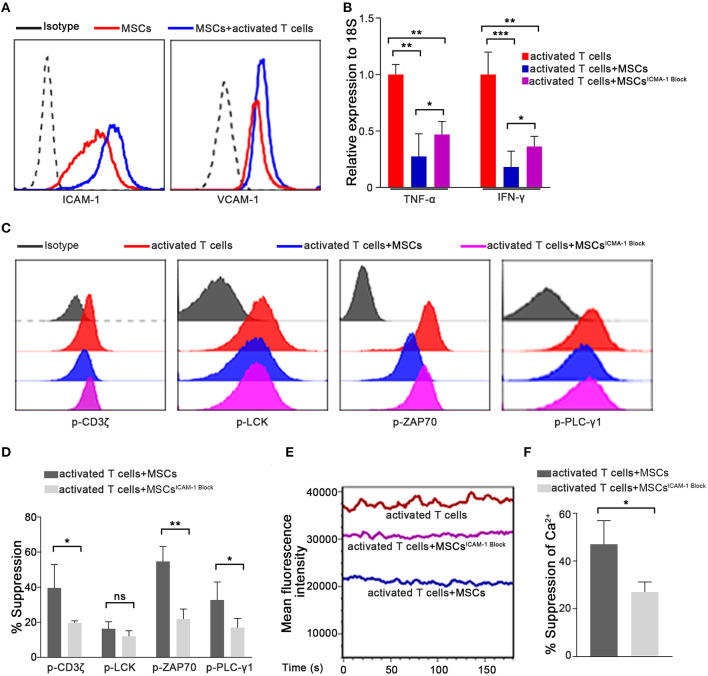
The ability of MSCs to rapidly suppress activated T cell cytokine transcription is dependent on ICAM1-mediated cell-to-cell contact. (A) Expressions of ICAM-1 and VCAM-1 on the membranes of MSCs determined by flow cytometry are shown. All experiments were repeated at least three times using the sixth passage MSCs. (B) The mRNAs abundances of TNF-α and IFN-γ in activated T cells. Data are shown for activated T cells, activated T cells cocultured with MSCs, and activated T cells cocultured with ICAM-1-blocked MSCs. (C) Phosphorylation levels of CD3ζ, LCK, ZAP70, and PLC-γ1 in activated T cells from the three groups described above were examined by flow cytometry. The results presented are representative of those obtained from three independent experiments. (D) Bar graphs show the suppression percentages of p-CD3ζ, p-LCK, p-ZAP70, and p-PLC-γ1. Data are shown for activated T cells cocultured with MSCs and activated T cells cocultured with ICAM-1-blocked MSCs. All experiments were repeated three times. (E) Cytosolic Ca2+ levels were tested by flow cytometry. The mean fluorescence intensity (MFI) is shown. The experimental groups are the same as described in (B). (F) Suppression percentages of the Ca2+ level in activated T cells from the coculture groups. The results are representative of three independent experiments. Data are presented as the mean ± SEM for each group. Significant differences are indicated as follows: ns, no statistical significance; *p < 0.05, **p < 0.01, and ***p < 0.001.